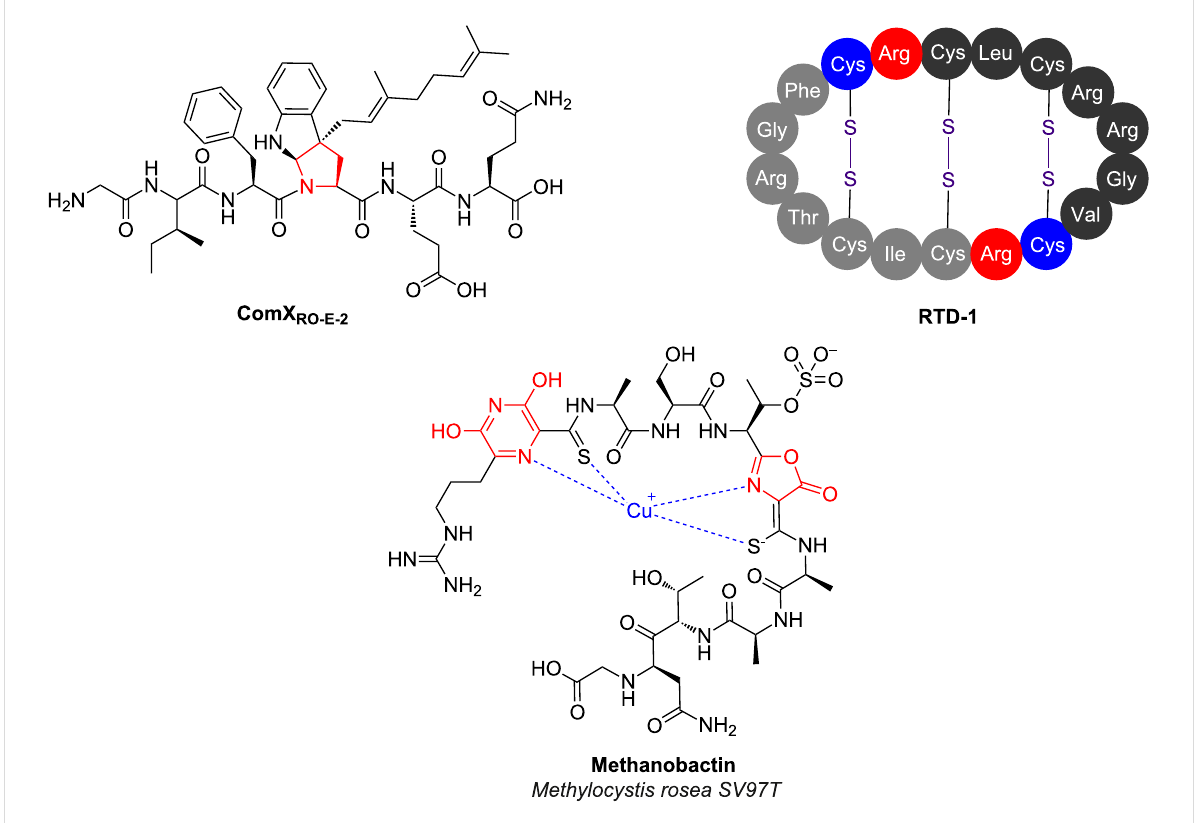
Figure 11: RiPPs with uncharacterised mechanisms of cyclisation. Unusual heterocycles in ComX and methanobactin are indicated in red. RTD-1 is formed by the head-to-tail dimerisation of precursor peptides encoded on two separate